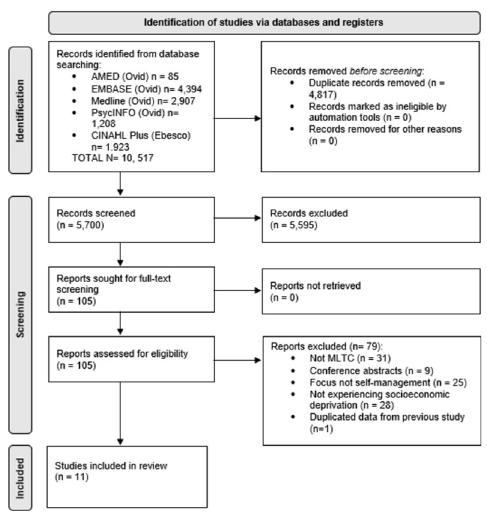
Fig 1. PRISMA flow